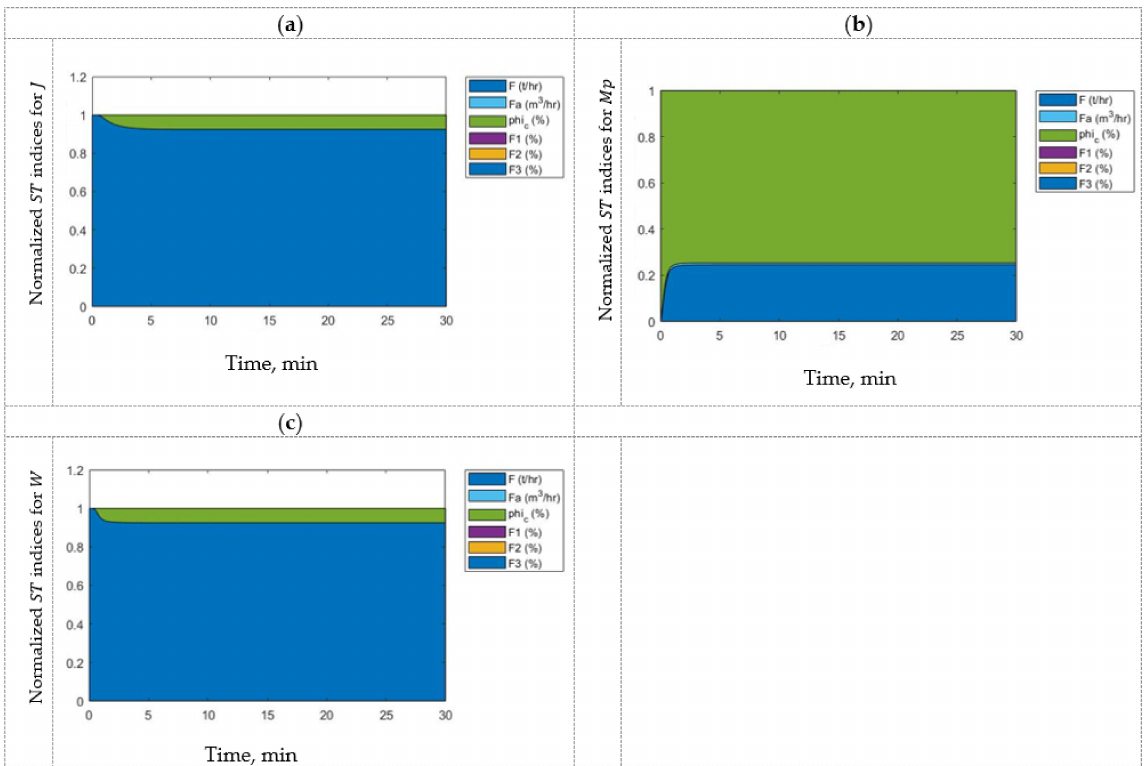
Figure 4. GSA results using ( a ) mill filling, ( b ) power consumption, and ( c ) mass retained as output